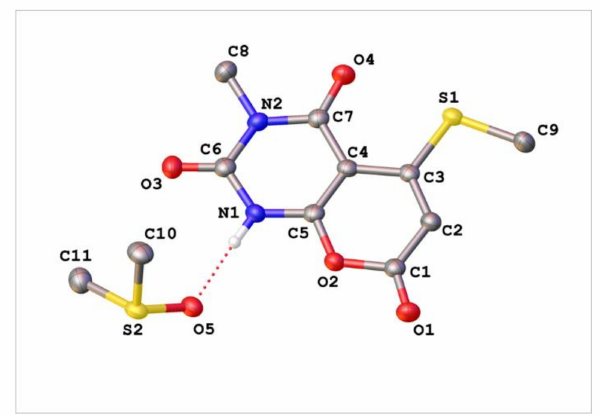
Figure A1. Crystal structure of compound 2c (DMSO solvate). In this figure and ???????? , ellipsoids were rendered at the 50% probability level. Hydrogen atoms have been omitted for clarity except for those bound to heteroatoms.